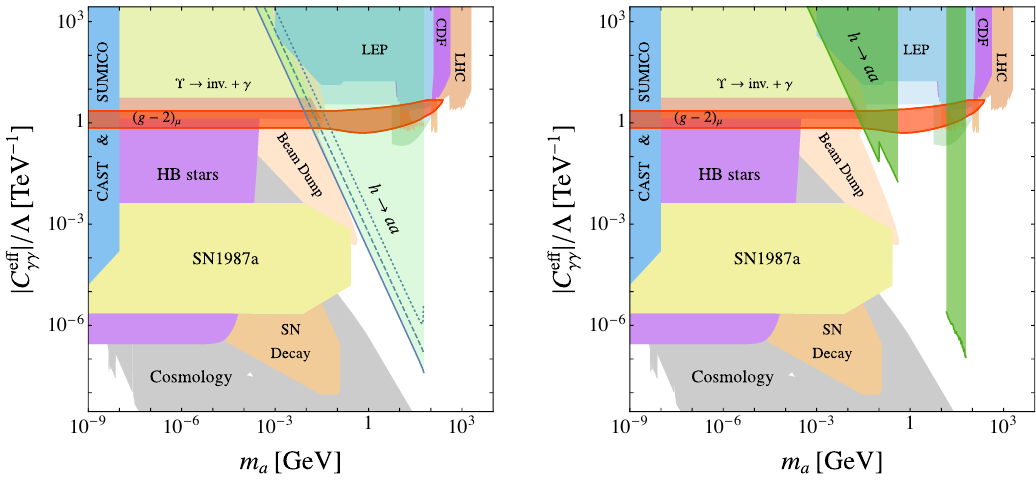
Figure 17 . Constraints on the ALP mass and coupling to photons derived from various experiments (colored areas without boundaries, adapted from [24]) along with the parameter regions that can be probed using the Higgs decays h aa 4 (cid:13) . The left panel shows the reach of LHC Run-2 with ! ! 300 fb (cid:0) 1 of integrated luminosity (shaded in light green). We require at least 100 signal events. The contours correspond to C e(cid:11) = (cid:3) 2 = 1 TeV (cid:0) 2 (solid), 0 : 1 TeV (cid:0) 2 (dashed) and 0 : 01 TeV (cid:0) 2 (dotted). ah j j The red band shows the preferred parameter space where the ( g 2) (cid:22) anomaly can be explained at (cid:0) 95% CL. The right panel shows the regions excluded by existing searches for h (cid:13)(cid:13) and h 4 (cid:13) ! ! (shaded in dark green), where we assume C e(cid:11) = (cid:3) 2 = 1 TeV (cid:0) 2 ah j j